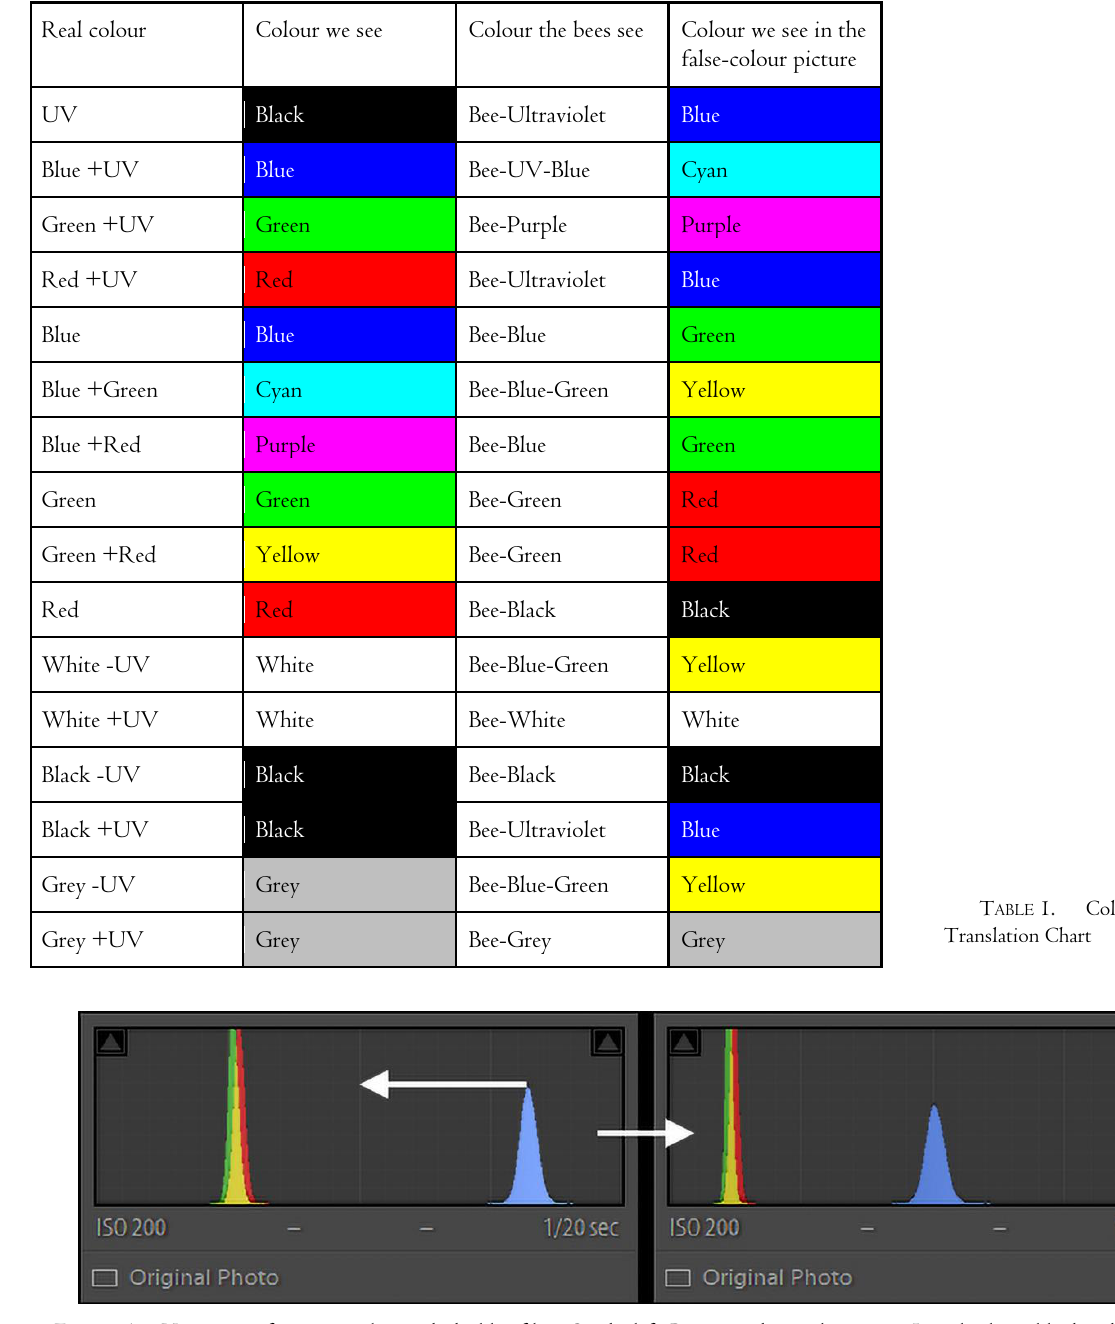
F IGURE 6. Histogram of a picture taken with the blue filter. On the left: Picture without adjustments. It is clearly visible that the blue channel of the picture is overexposed. On the right: The same picture after adjusting the brightness. The peak of the blue channel is now located in the middle and has the correct